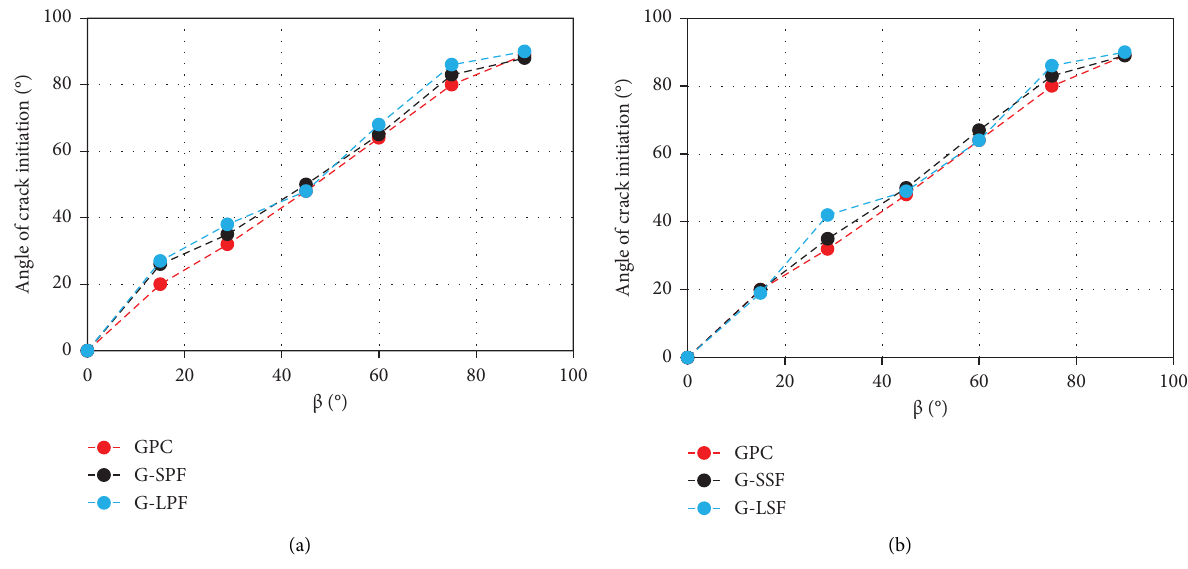
Figure 15: Te relationship between the angle of crack initiation and β